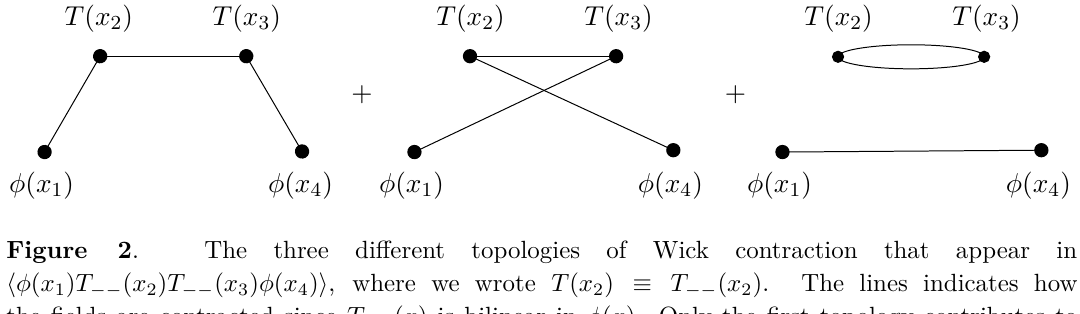
The lines indicates